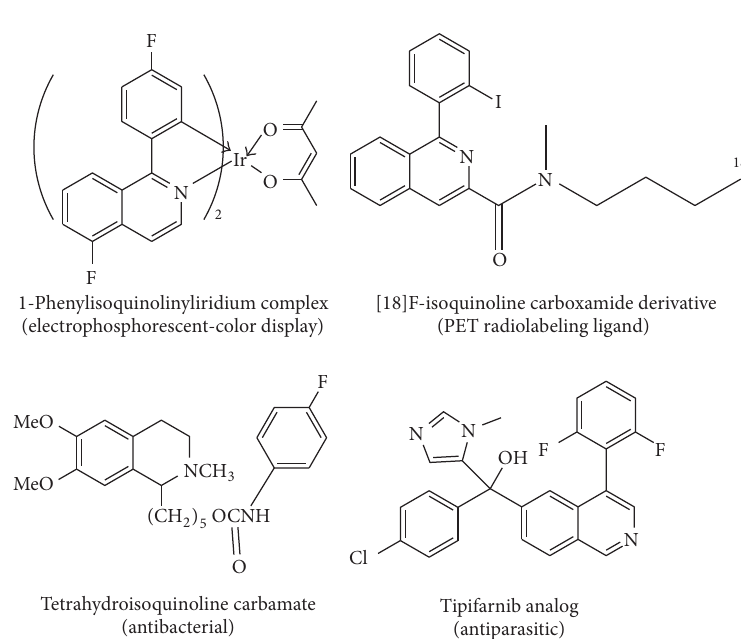
Figure 3: Selected fluorinated isoquinoline derivatives with medicinal and industrial applications.